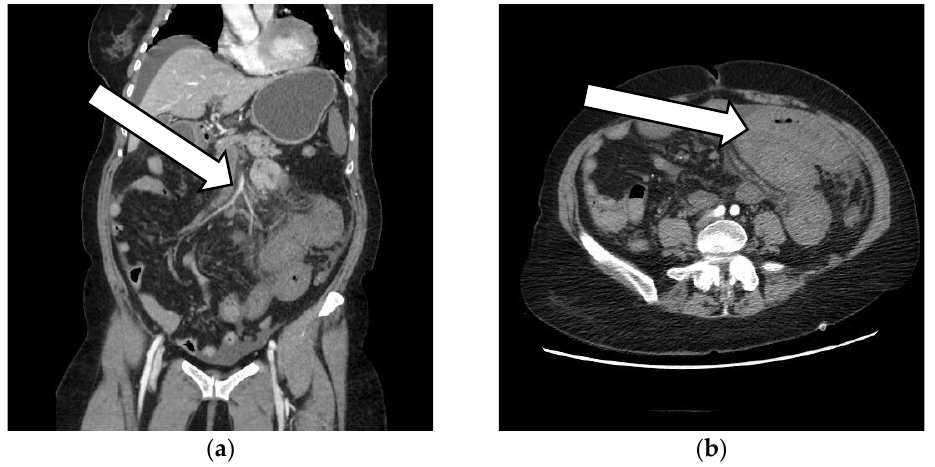
Figure 2. CT scan at admission. ( a ) Arrow is pointing toward the first branches of the superior mesenteric artery that appears to receive normal contrast, but with decreasing intensity; ( b ) Arrow is pointing toward the distended first loops of the jejunum, with thickened walls that do not appear to receive contrast.